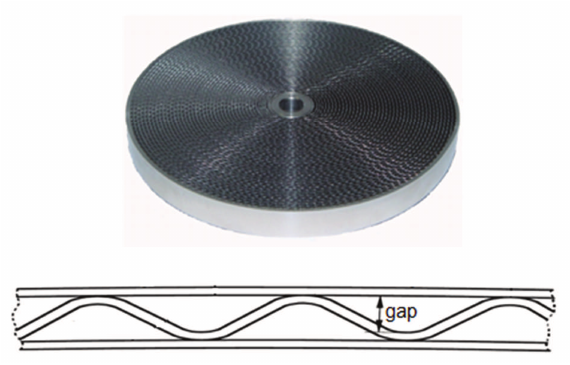
Fig. 1. Example of function element of a flame arrester [4] There are no certified flame arresters for Group I (in- tended for an operation in underground mines).